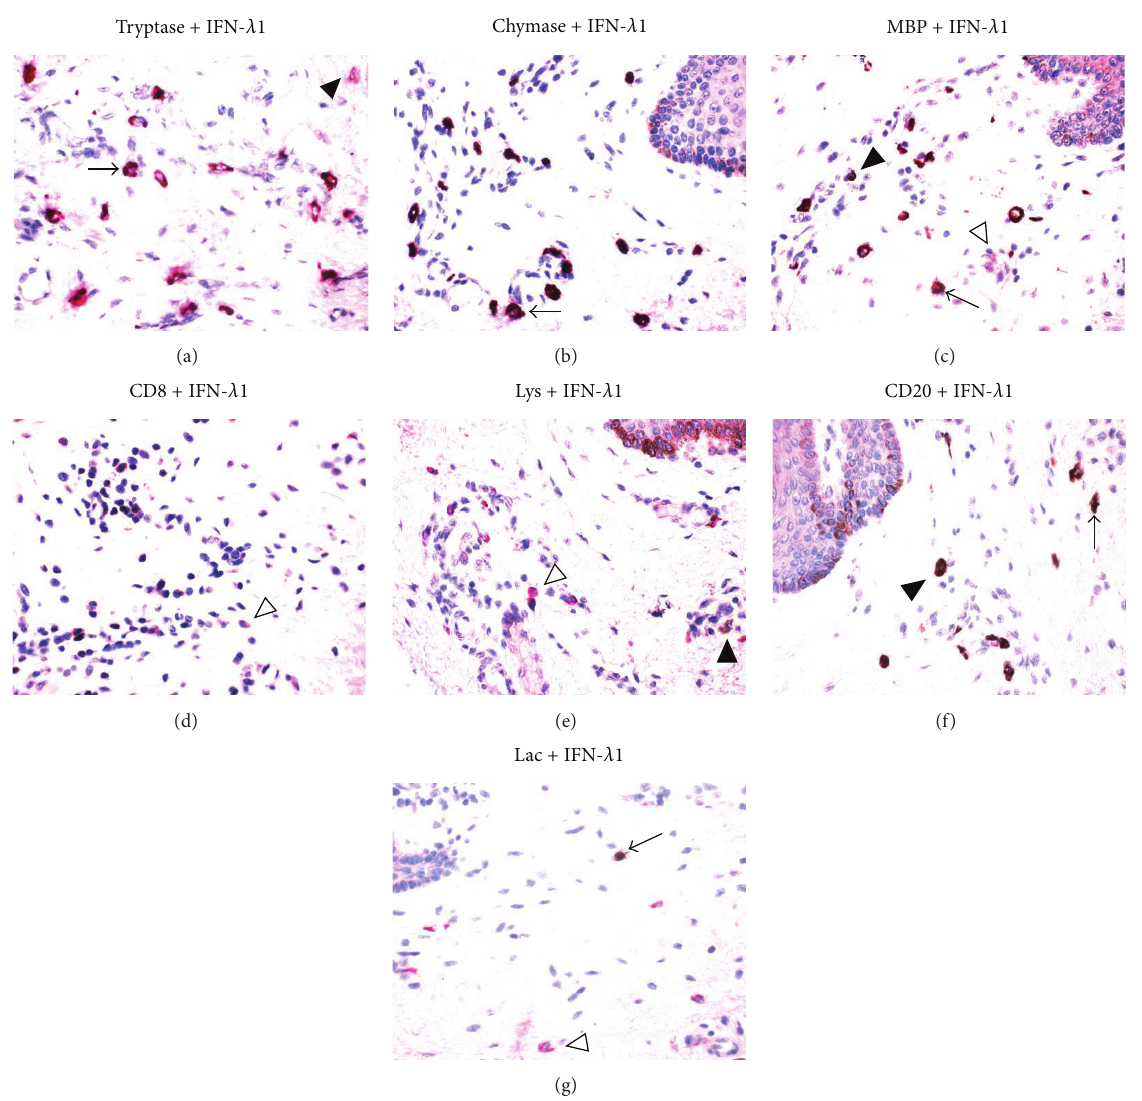
Figure 4: Double labeling immunohistochemical analysis of the expression of interferon- (IFN-) 𝜆 1 in human skin tissue. (a–g) showed representative graphs of the expression of IFN- 𝜆 1 (in brown, open arrow head) in (a) tryptase + (in red, solid arrow head), (b) chymase + (in red) mast cells, and (c) major basic protein (MBP) + eosinophils (in red, solid arrow head); IFN- 𝜆 1 (in red, open arrow heads) in (d) CD8 + T cells (in brown), (e) lysozyme (Lys) + macrophages (in brown, solid arrow head), (f) CD20 + B cells (in brown, solid arrow head), and (g) lactoferrin (Lac) + neutrophils (in brown). Double labeled cells were in brown and red (arrows). Magnification was × 400. See Table 3.